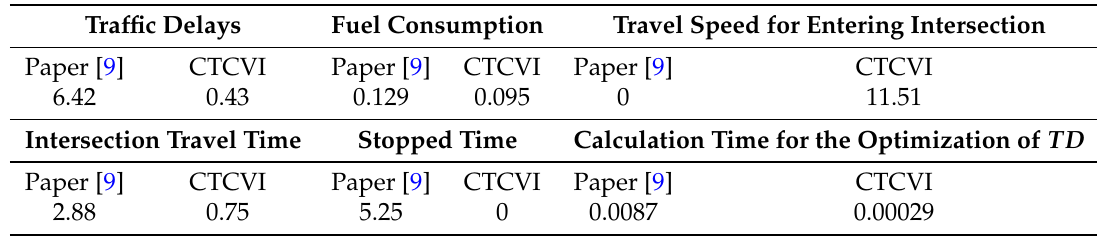
Table 5. Comparison between the CTCVI and Reference